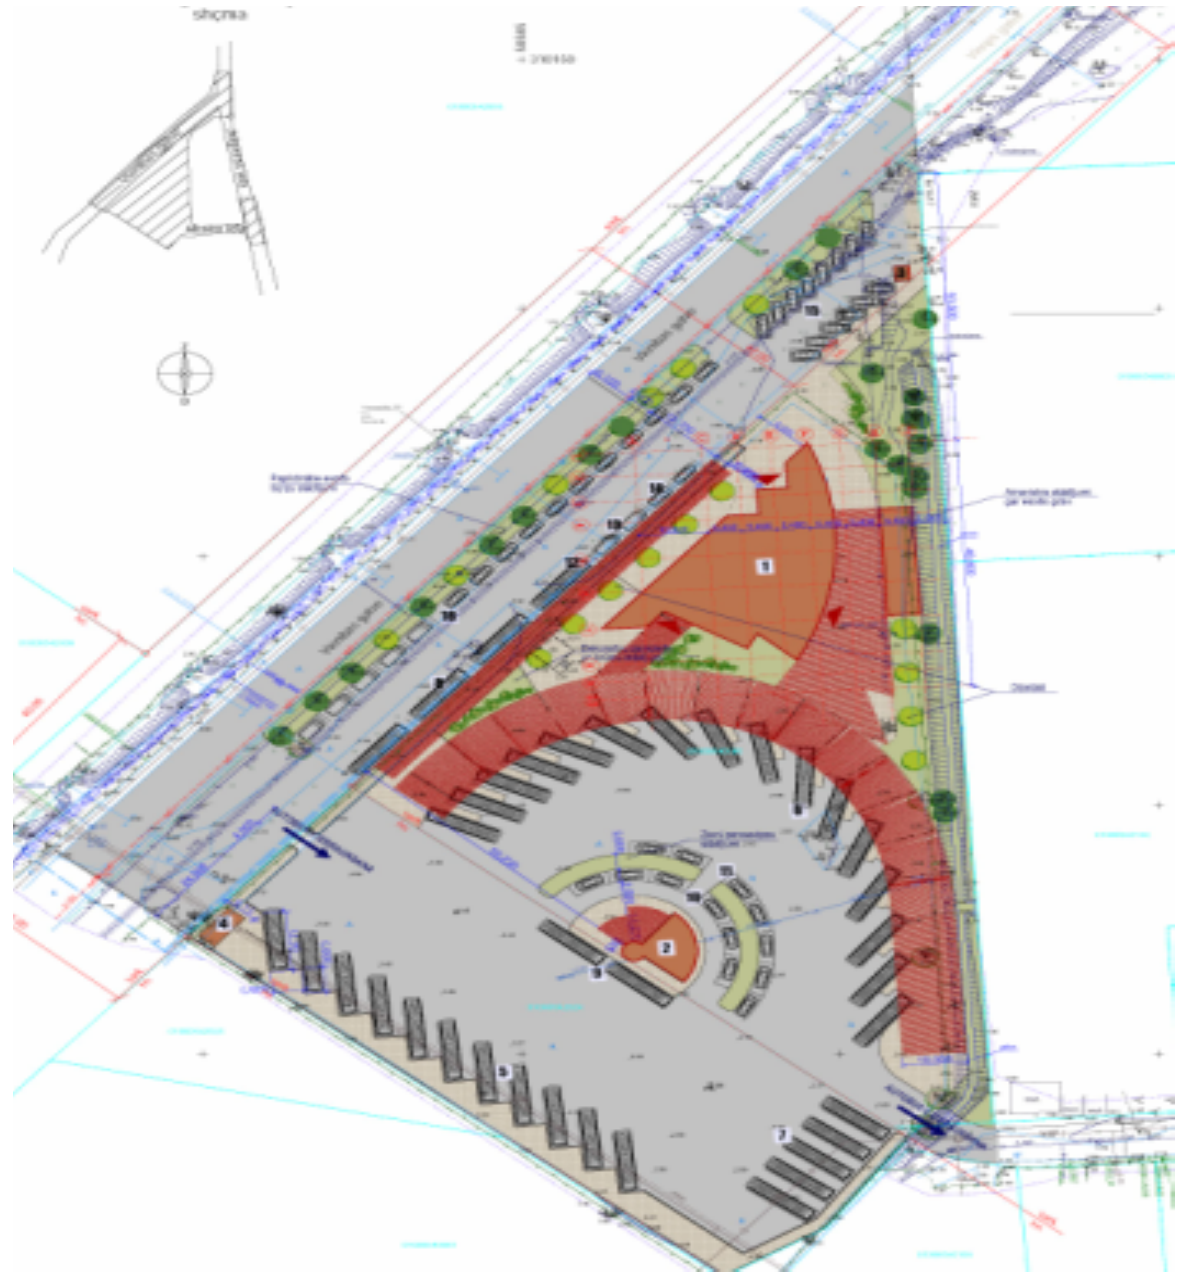
Fig 3. Plan of a new Riga Coach Terminal on Vien ī bas Gatve, Street in